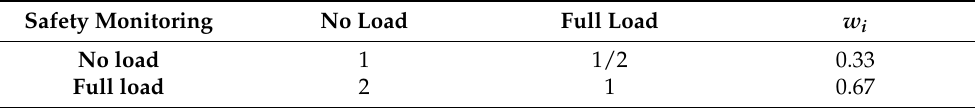
Table 22. Important degree judgment matrix for safety monitoring under different operating conditions.